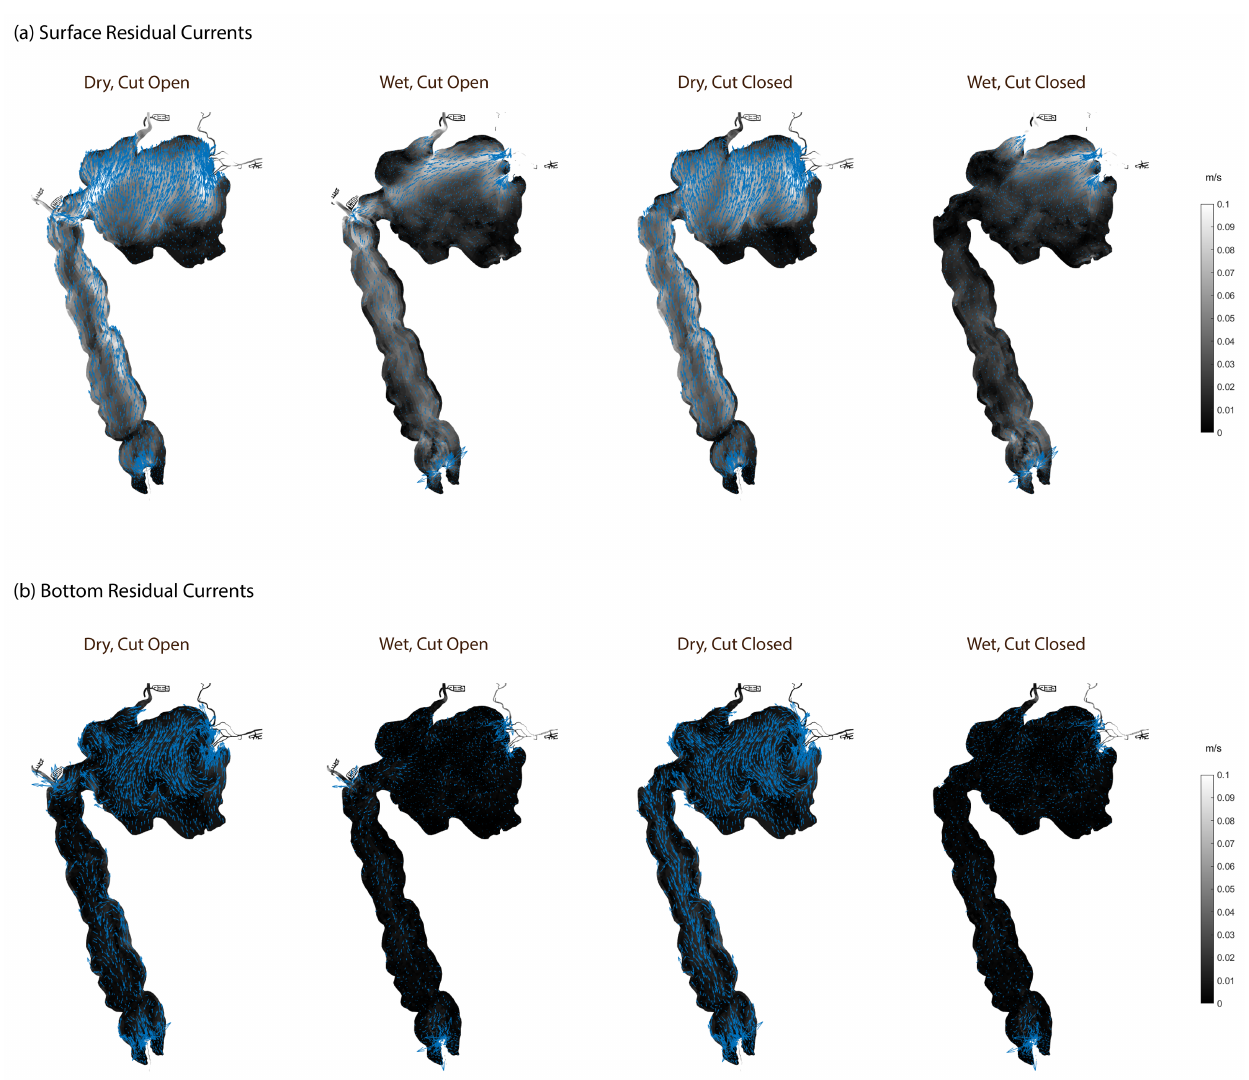
Figure 13. Plan views of residual currents in selected scenarios. The black–white colour gradient indicates the total current speed; the blue arrows indicate the current